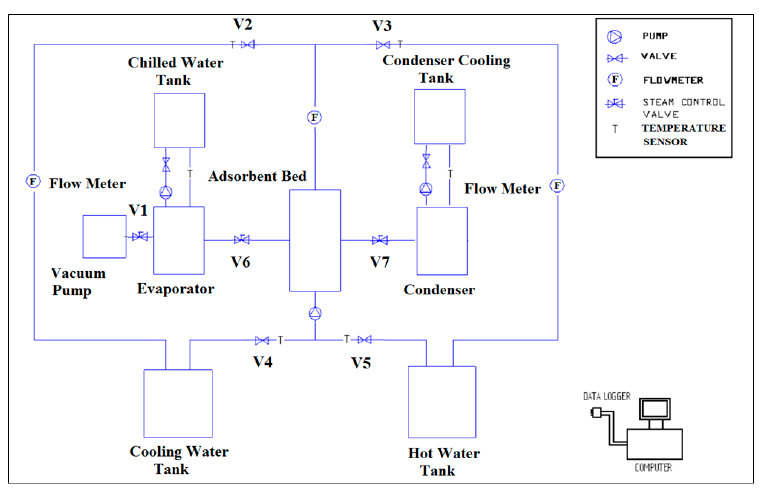
Figure 1. Schematic view of the adsorption cooling test rig with the wire woven fins.